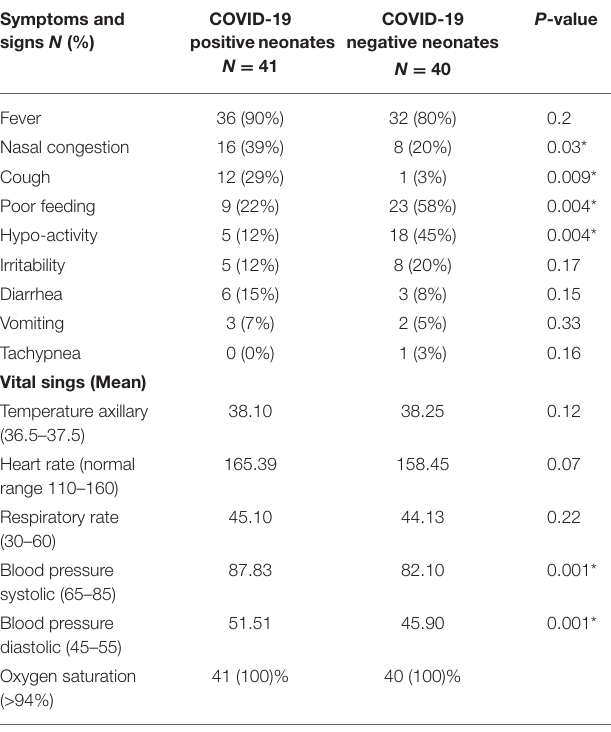
TABLE 2 | Clinical characteristic for both groups. TABLE 3 | Biochemical characteristics for both